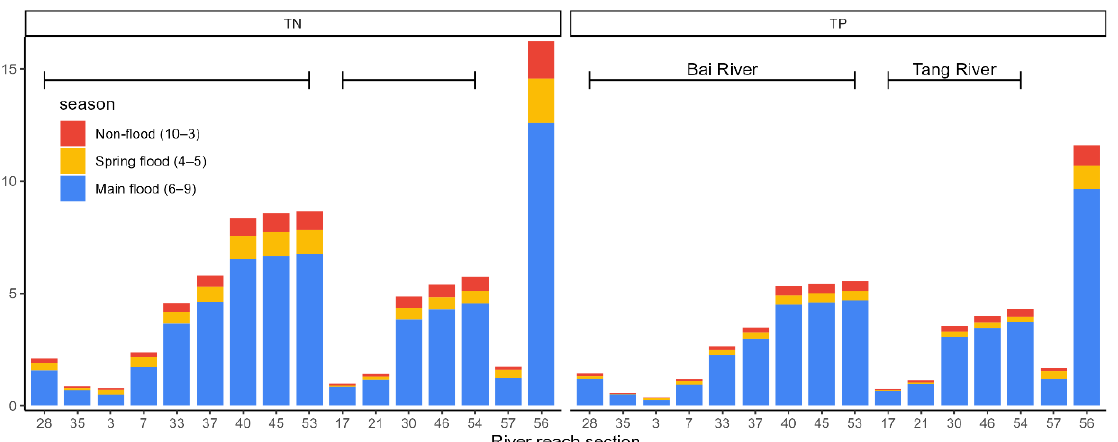
Figure 5. Seasonal mean TN and TP loads transported with water out of the individual river reaches averaged over 2000–2019. Reaches numbered before 53 belong to the Bai River, and those numbered 17–54 belong to the Tang River. Reach 57 is the downstream tributary called the Gun River, and 56 is the watershed outlet of TRB.